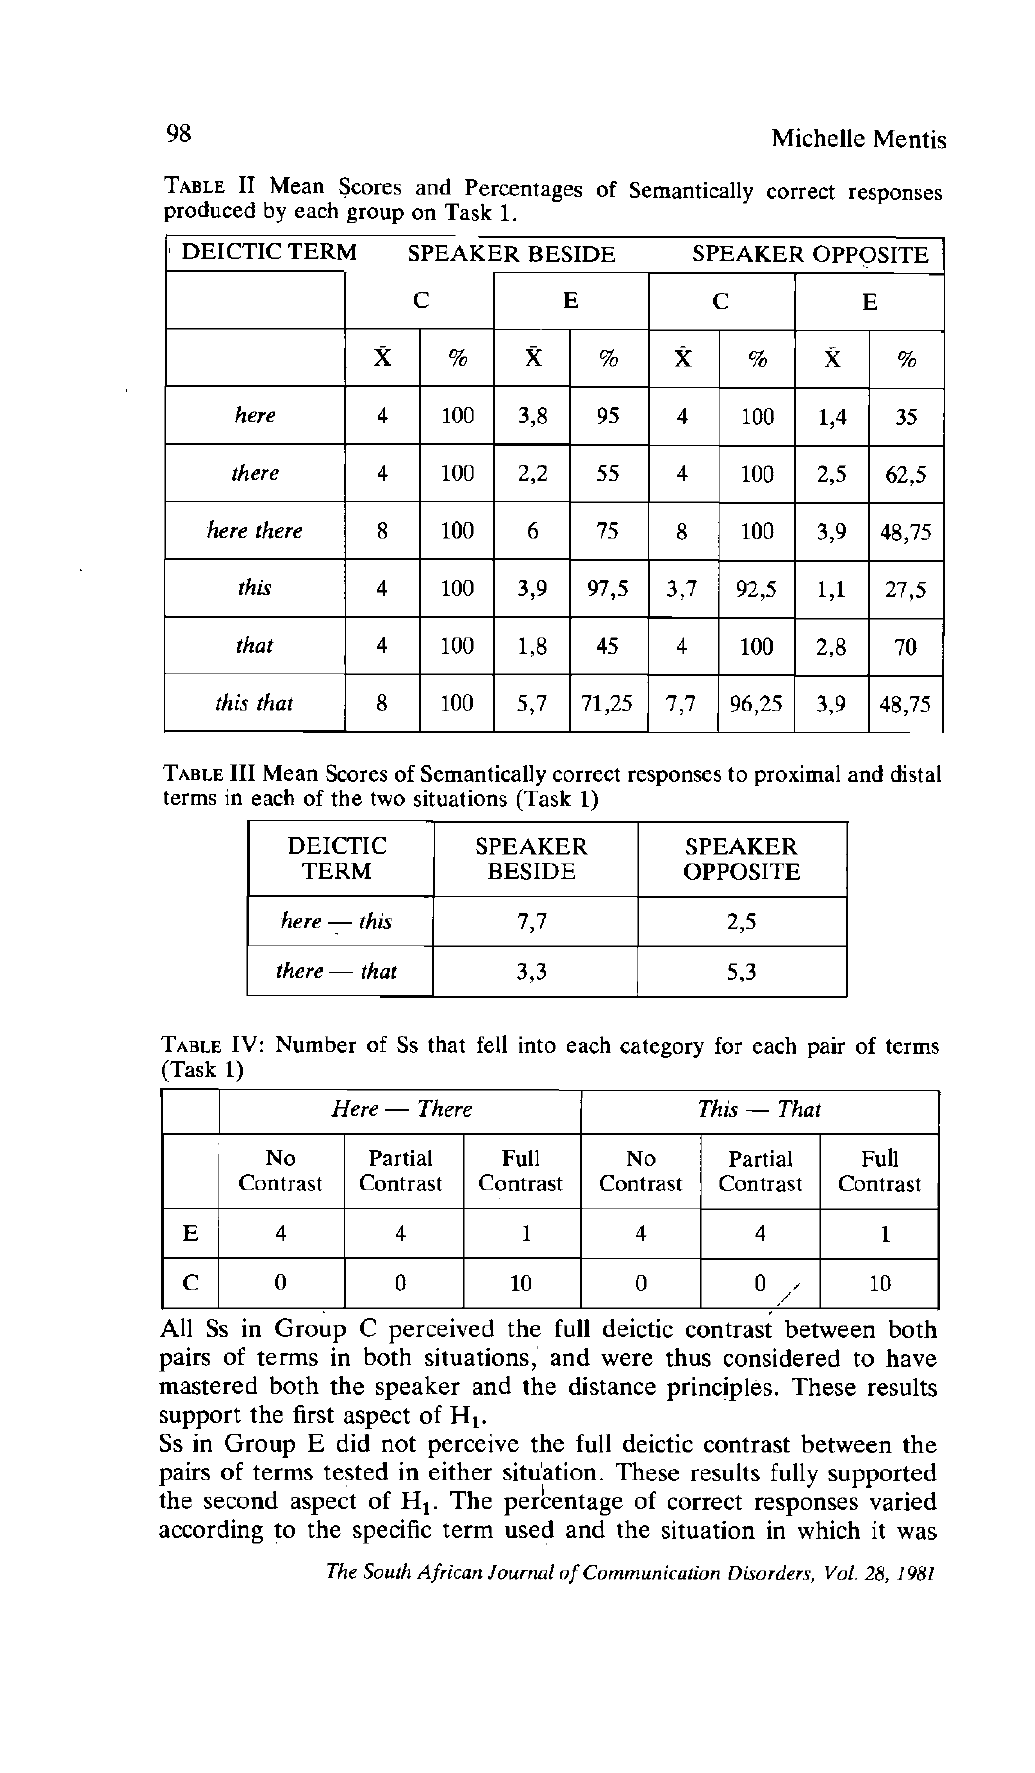
TABLE II Mean Scores and Percentages of Semantically correct responses produced by each group on Task 1.